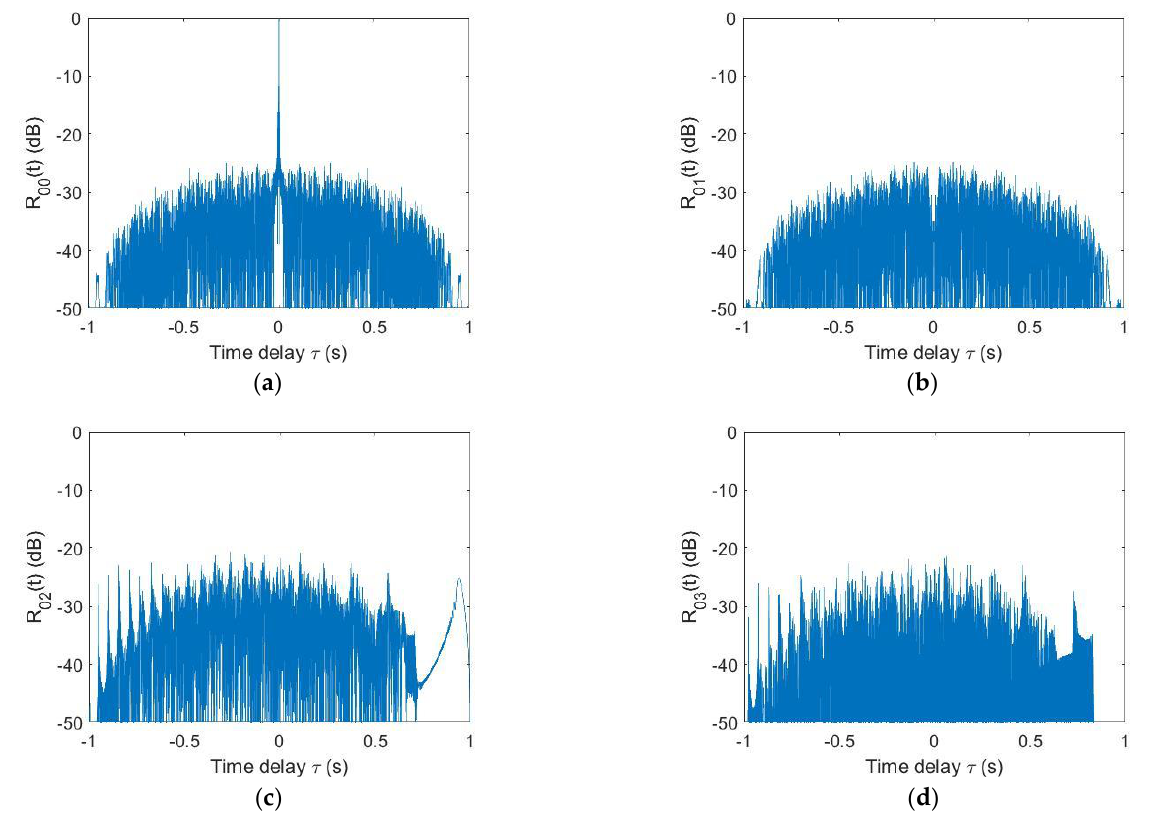
Figure 4. The orthogonality between waveforms, ( a ) Autocorrelation of the FT, ( b ) cross-correlation of the FT/FF and FT, ( c ) cross-correlation of the RT and FT and ( d ) cross-correlation of the RT/FF and FT.